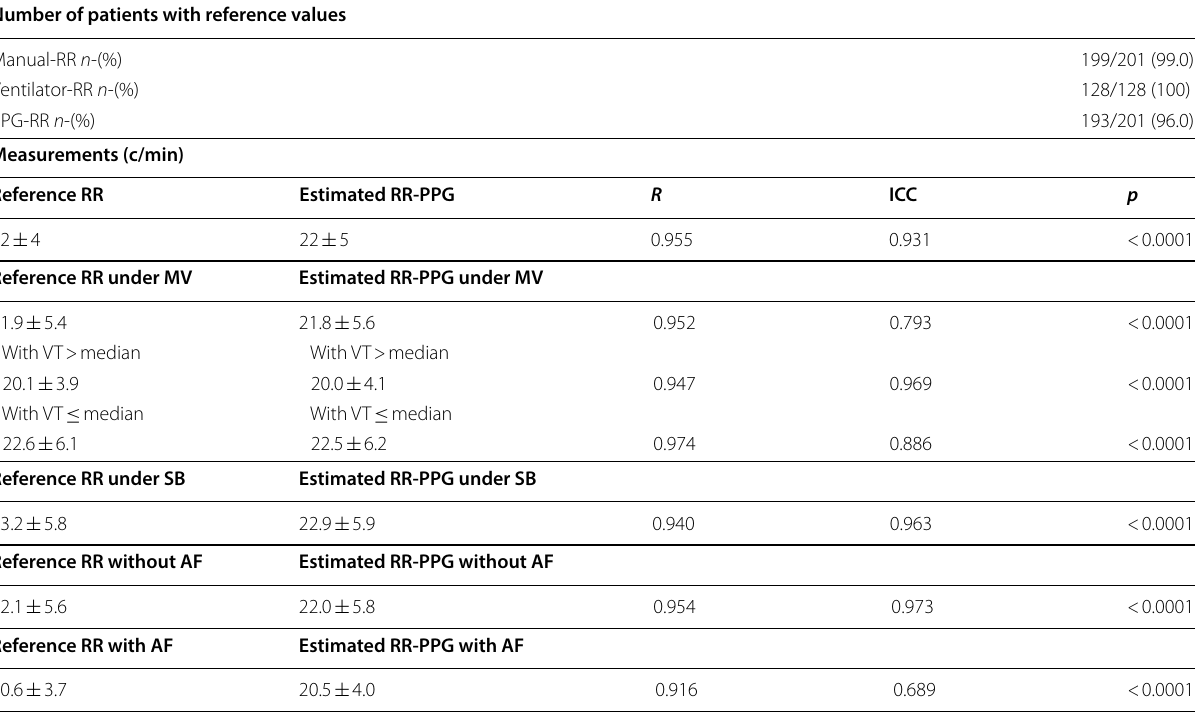
Values are provided as n -(%) or mean SD (b/mn), unless specified otherwise. R, Pearson’s correlation coefficient; ICC, intraclass correlation coefficient for average ± measurements, was assessed to evaluate the reliability of measurements; a p value < 0.01 was considered statistically significant for a bilateral test Reference RR values are provided as the chronometric measurement measured over 30 s under spontaneous ventilation or as the ventilatory rate for patients under ventilatory assistance RR, respiratory rate; PPG, plethysmographic measurement; Manual-RR, chronometric evaluation of the RR, over a 30-s period; Ventilator-RR, RR value provided by the ventilator in case of mechanical ventilation; PPG-RR, estimated respiratory rate using the plethysmographic curve analysis; MV, mechanical ventilation; SN, spontaneous breathing; AF, atrial fibrillation; VT, tidal volume (median tidal volume 475 mL) =